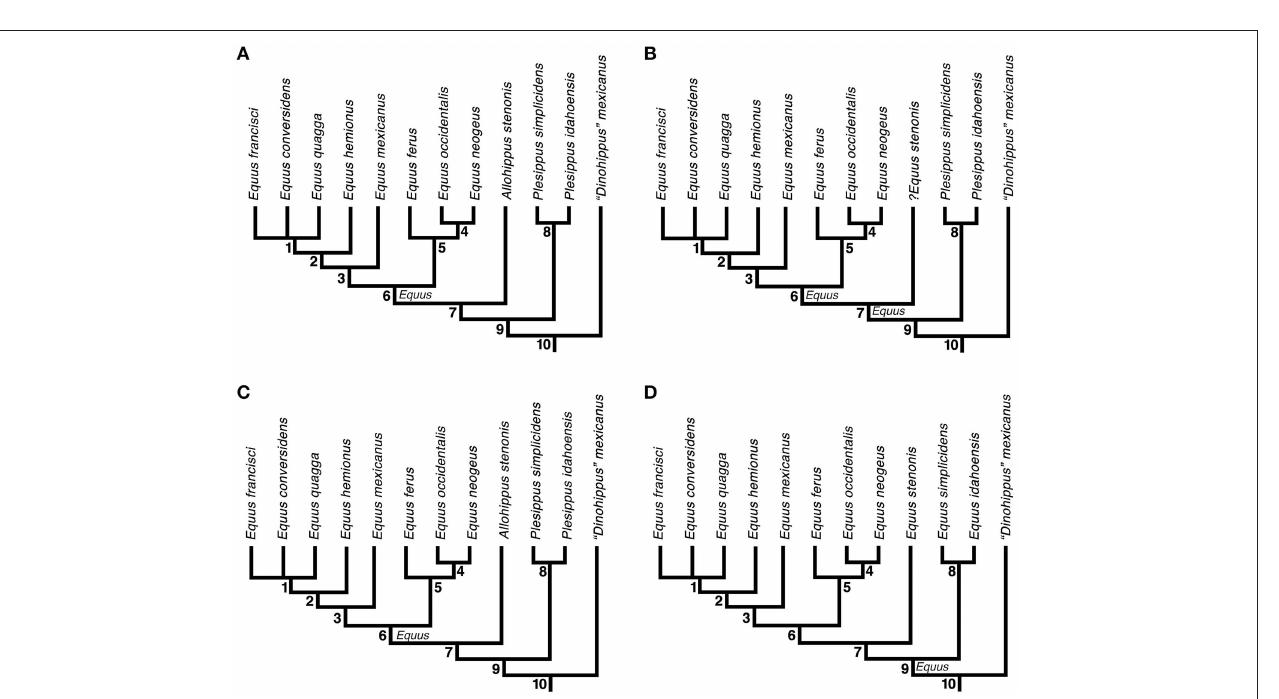
genus has not been reached (Wood and Collard, 1999; Collard and Wood, 2007; Holliday, 2012; Antón et al., 2014; Wood,